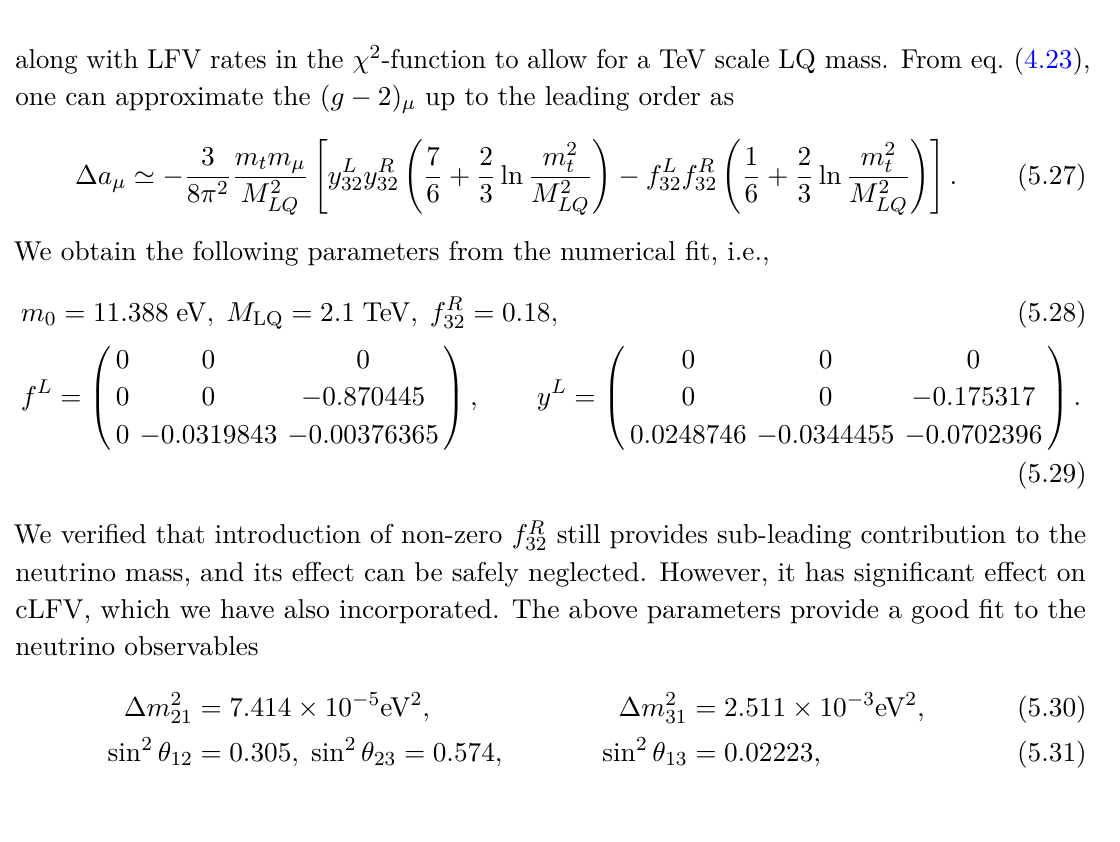
Figure 8 . Correlations between µ → eγ and µ − e conversion. Shaded colored regions are ruled out by current data and dotted lines represent future